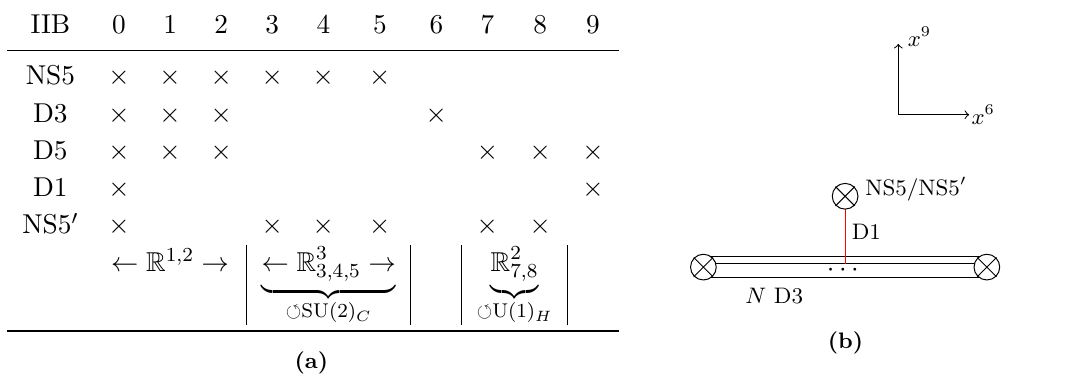
Figure 5. Brane realisation of vortex line